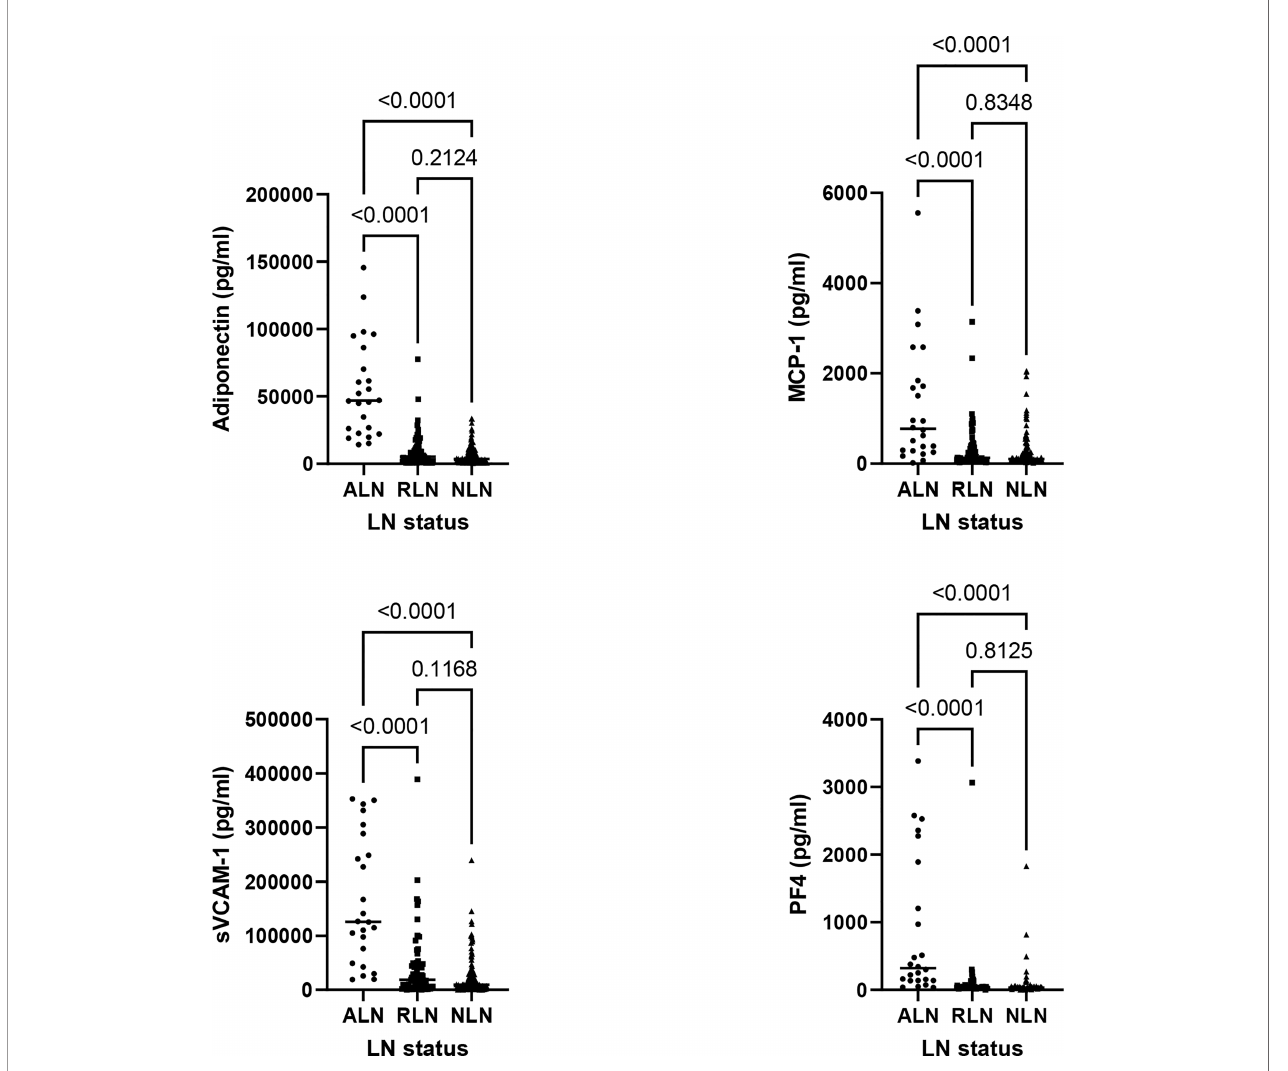
FIGURE 2 | Comparison of biomarker levels between active LN (ALN; n = 24, circles), remission LN (RLN; n = 79, squares) and non LN (NLN; n=144, triangles). For all graphs each symbol represents the determination from a single individual, with the median value for each group indicated by a horizontal line. The Kruskal-Wallis test was used to assess the differences in biomarker levels between ALN, RLN and NLN